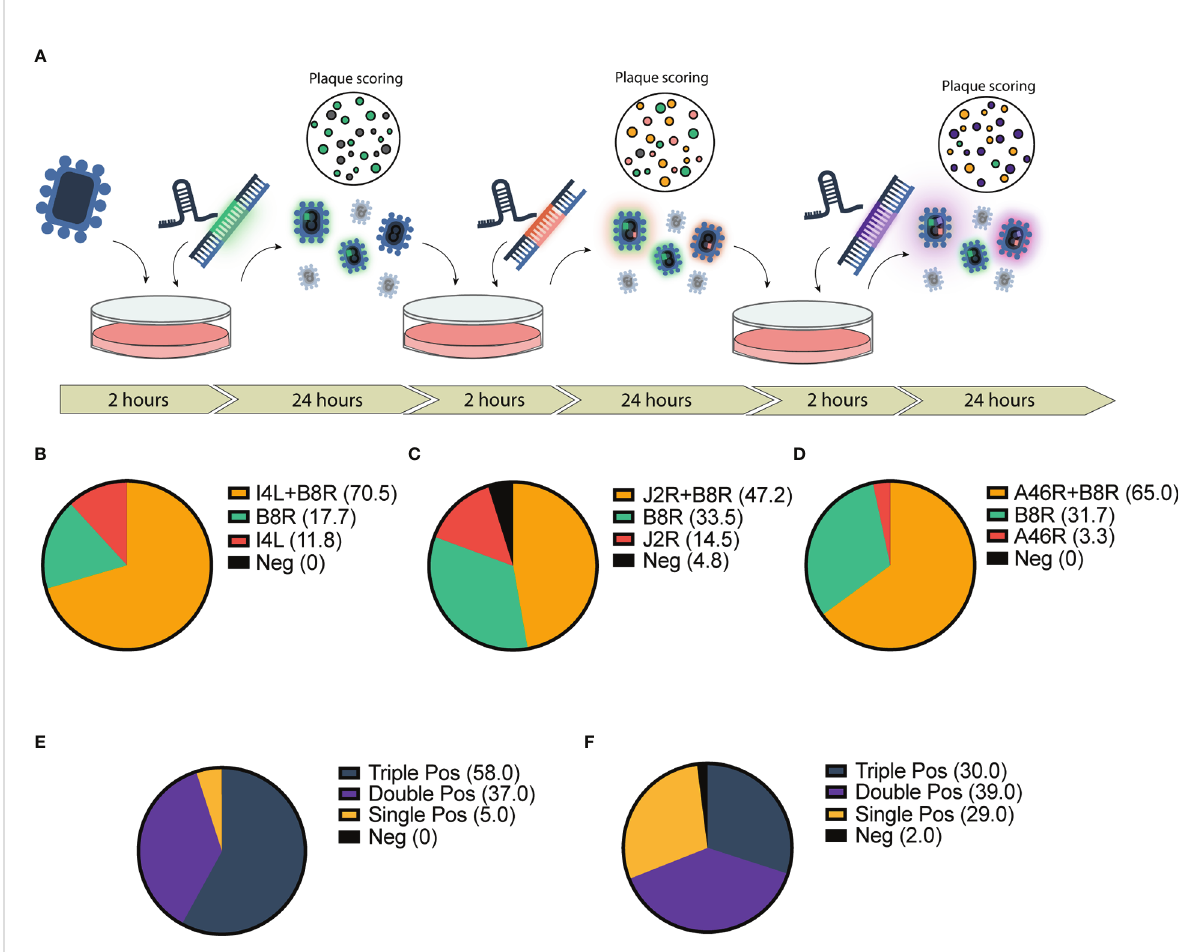
FIGURE 2 Application of CRISPR-mediated rapid rescue protocol to the accelerated rescue of multi-armed Vaccinia virus. (A) Timeline for rapid multi- arming of Vaccinia virus Copenhagen at multiple viral loci. Bulk virus is collected and used as inoculum for following infection/transfection and stored for scoring. (B – F) Scoring of bulk viral output following two-step infection transfection of Cop -B8R-I4L (B) Cop -B8R-J2R (C) and Cop -B8R-A46R (D) (n = 3). Three-step recombination resulting in Cop -B8R-I4L-A46R (E) and Cop -B8R-J2R-A46R (F) (n = 2). Loci are labelled in order of CARVE-mediated insertion of EGFP (B8R), mCherry (I4L and J2R), and iRFP720